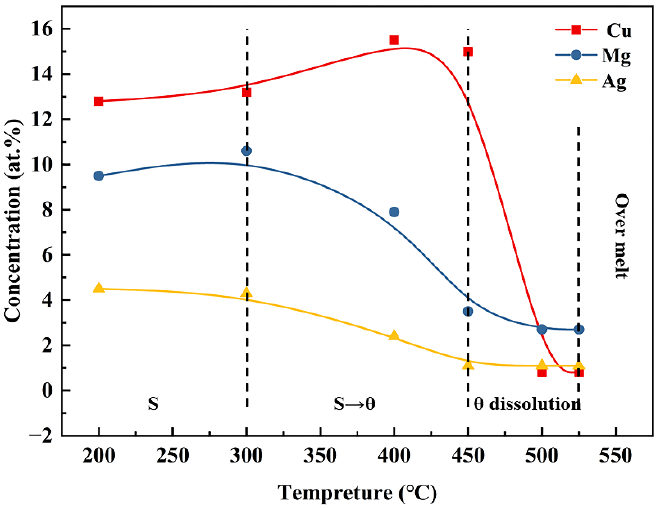
Figure 13. Evolution of elemental concentrations of Cu, Mg and Ag in S phase during homogenization.